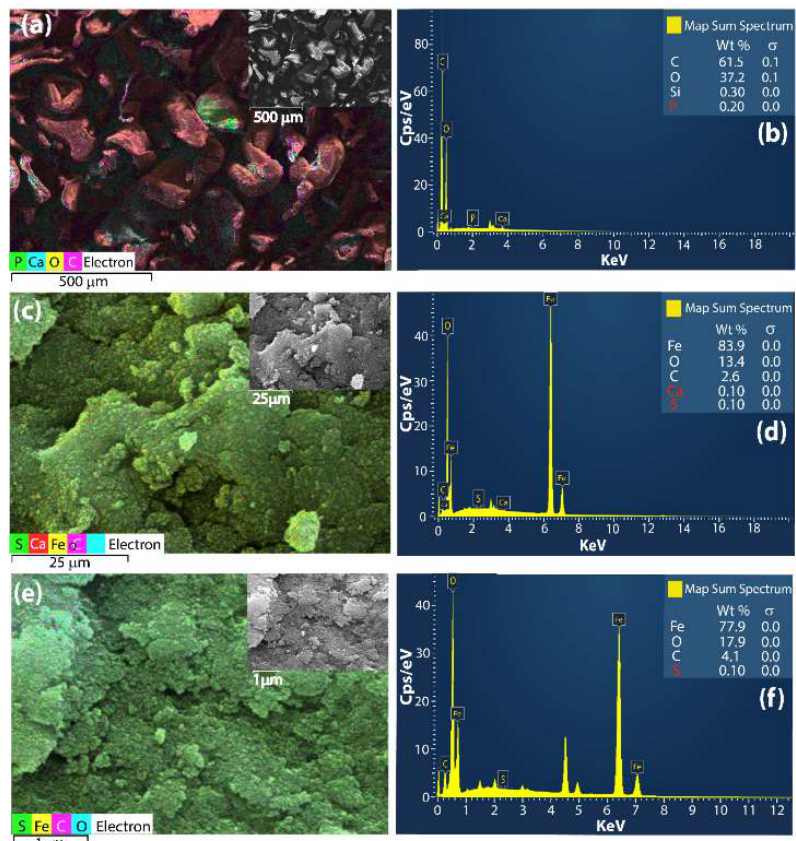
Figure 3. EDS maps, SEM images (inset) and EDS spectra of CHI ( a , b ), Fe 3 O 4 @CHI ( c , d ) and Fe 3 O 4 @CHI–GLU–CALA ( e , f ).